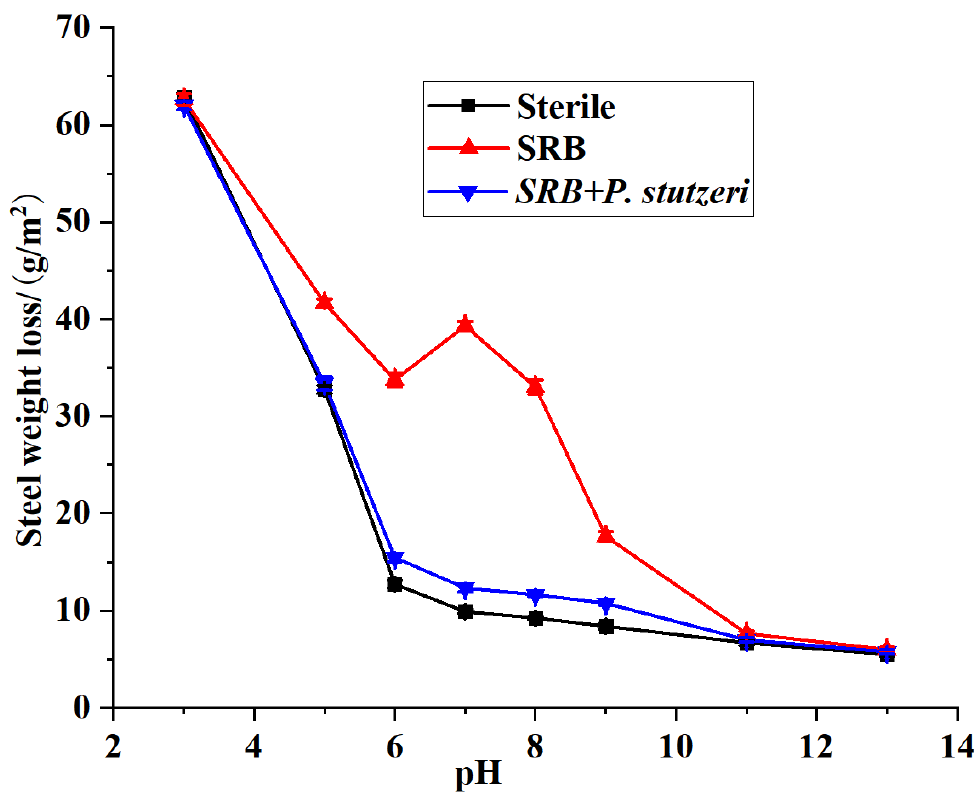
Figure 8. Weight loss curves of X70 steel under different pH.